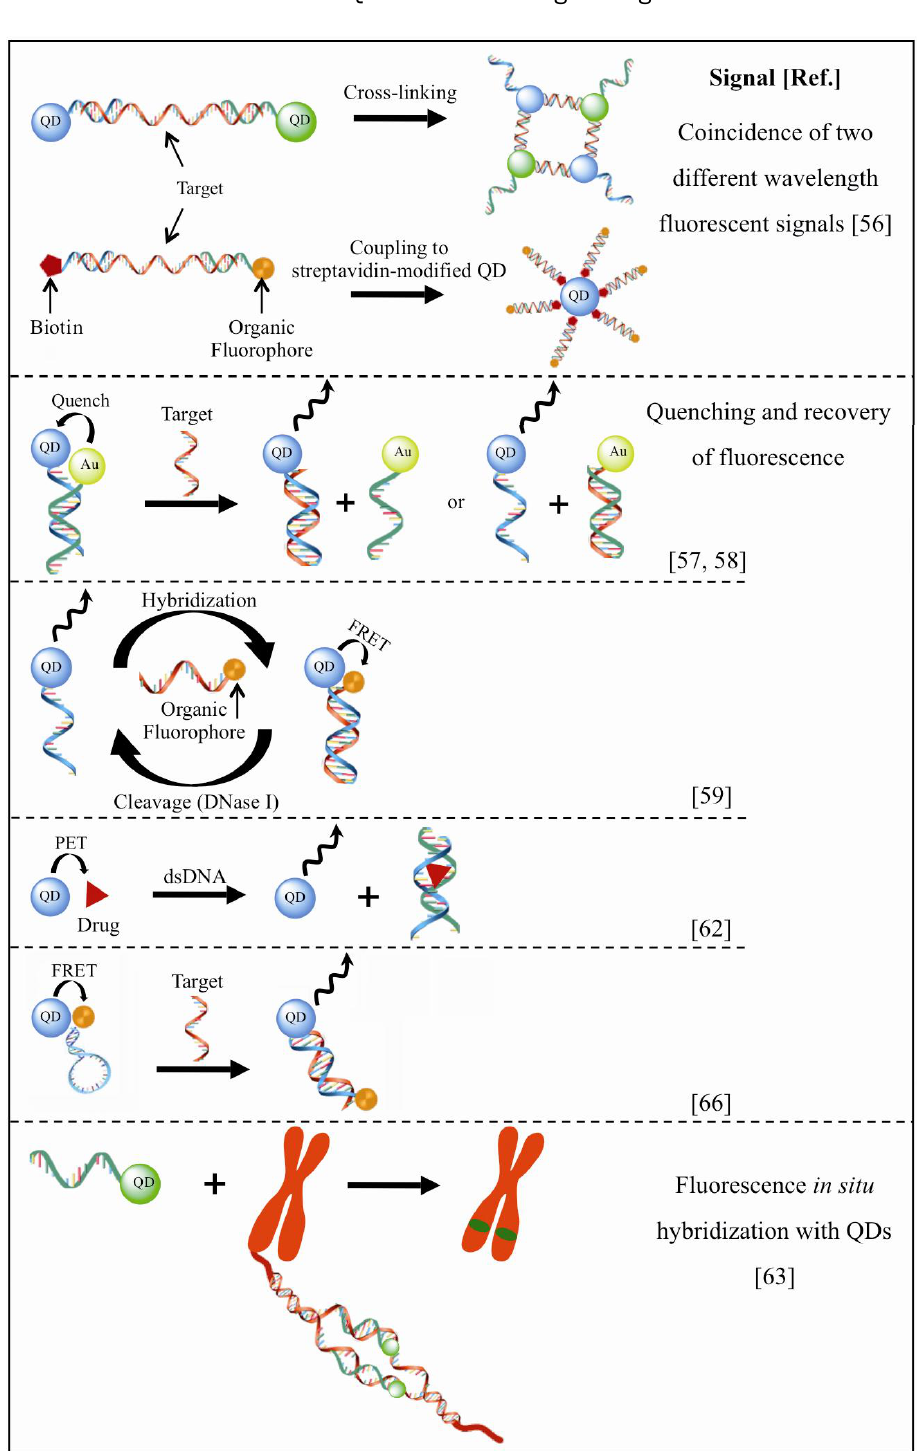
Figure 3. Illustration of various QD-based sensing configurations for nucleic